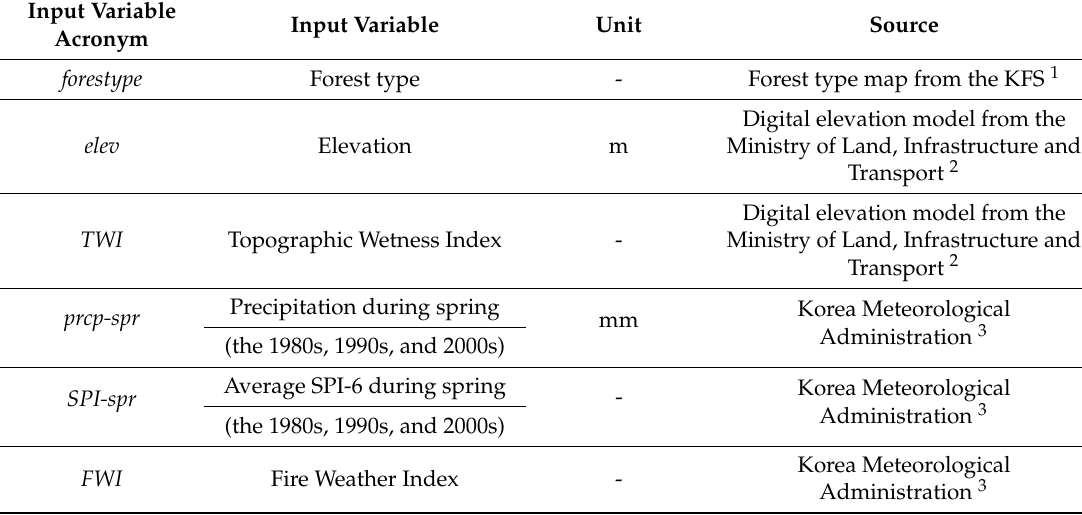
Table 1. Input variables used to estimate forest fire